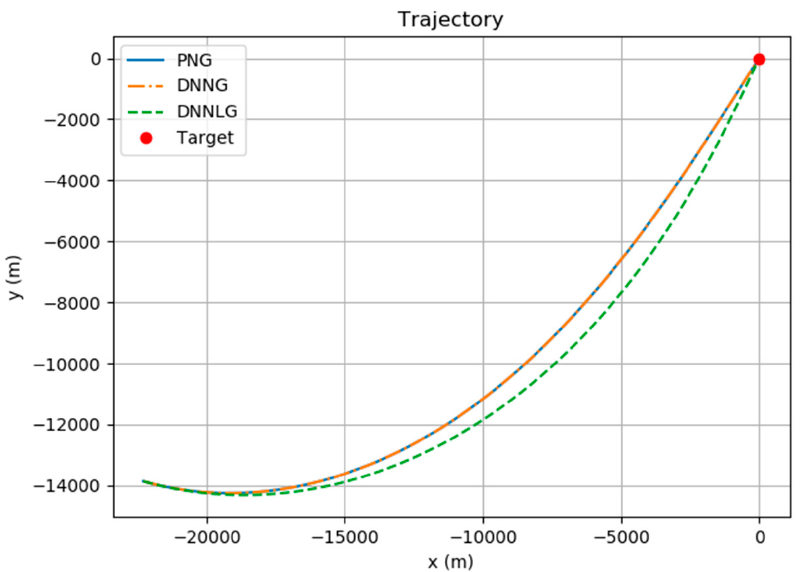
Figure 11. Comparison of the trajectory for all guidance law. Table 3. Results of DNNLG law for 100 random initial